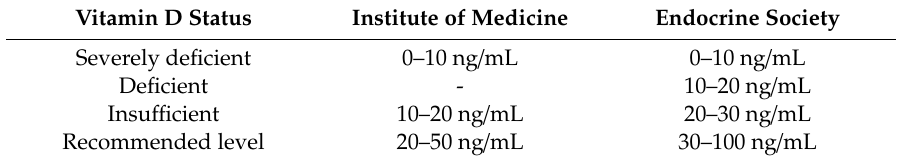
Table 1. Status of vitamin D level as provided by the Institute of Medicine* and Endocrine